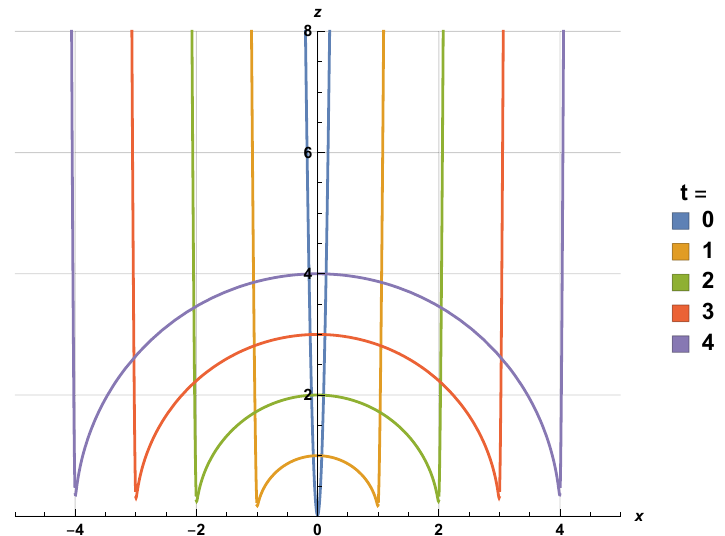
Figure 22 . Boundary surfaces of single joining quench at different t . a = 0 . 01. Note that the boundary surface at x < t is given by z 2 = ( t 2 (cid:31) (cid:30) (cid:29)(cid:28) 4( x 2 t 2 ) 3 t 2 a 2 1+ . Initially at t = 0, there is a sharp boundary surface localized z 2 = 1 − a 2 ( x 2 +3 t 2 ) ( t 2 x 2 ) 2 O −